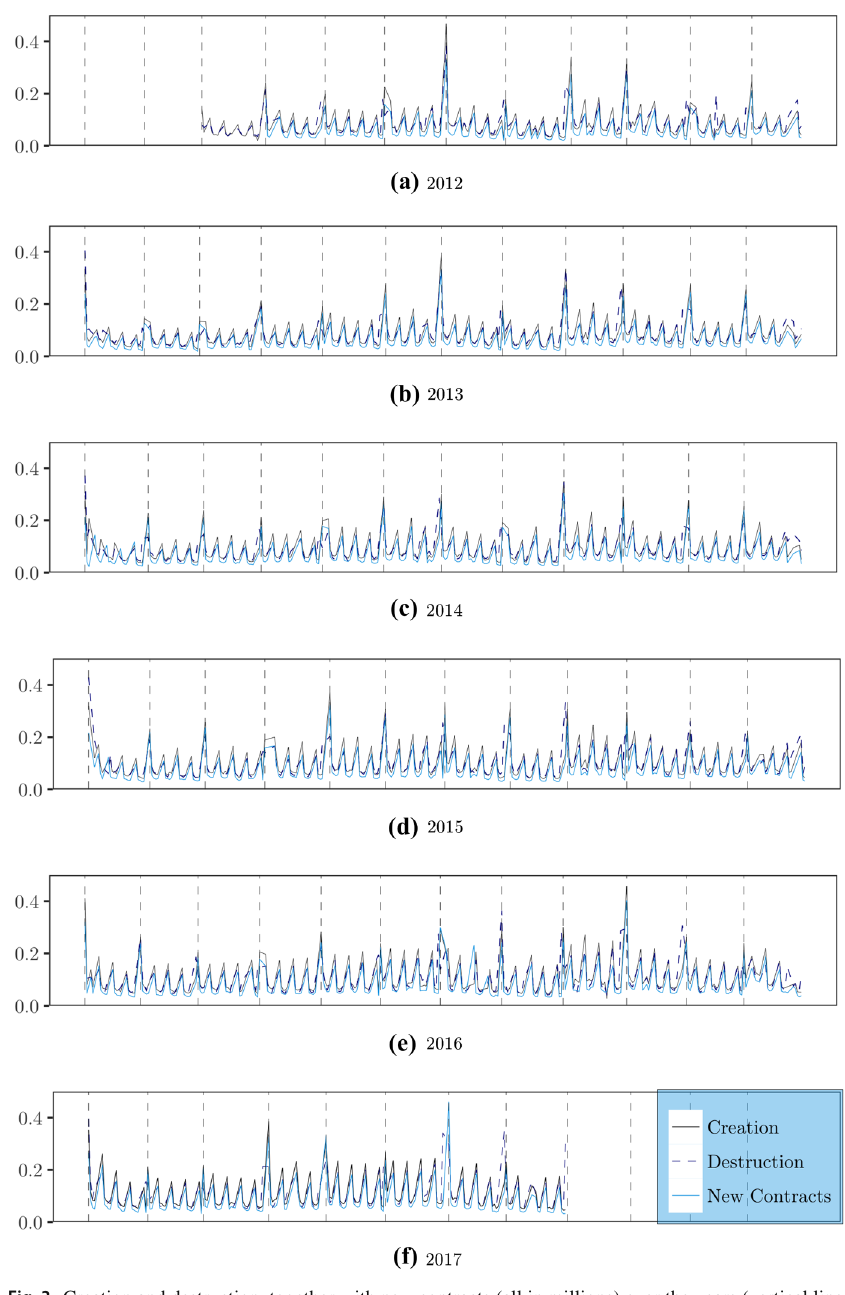
Fig. 3 Creation and destruction, together with new contracts (all in millions) over the years (vertical lines go first workday each